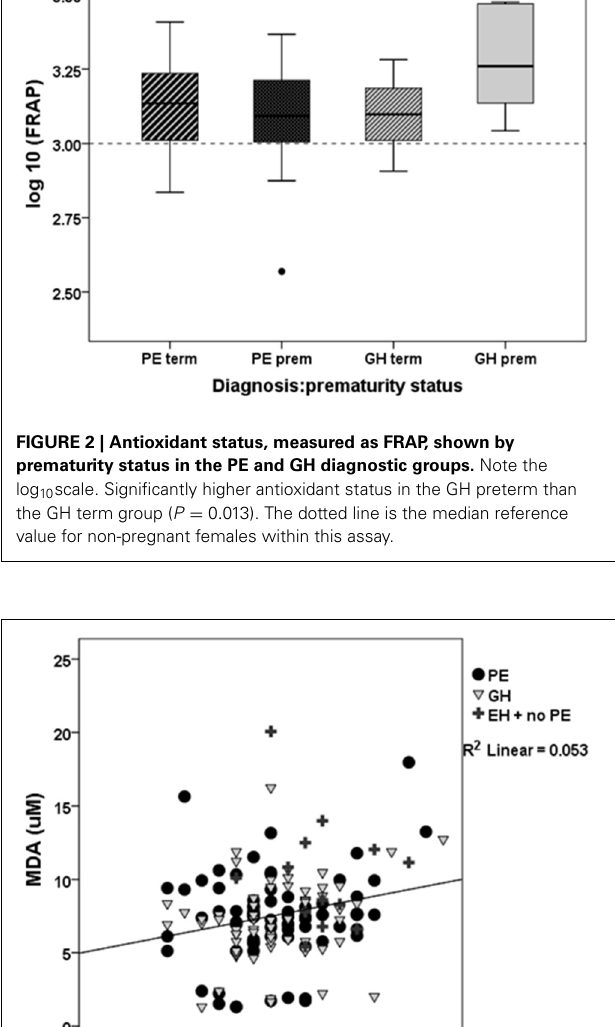
TBARS ( r = 0 . 248, P = 0 . 003; Figure 4 ). No such association was observed in the women who had a normotensive